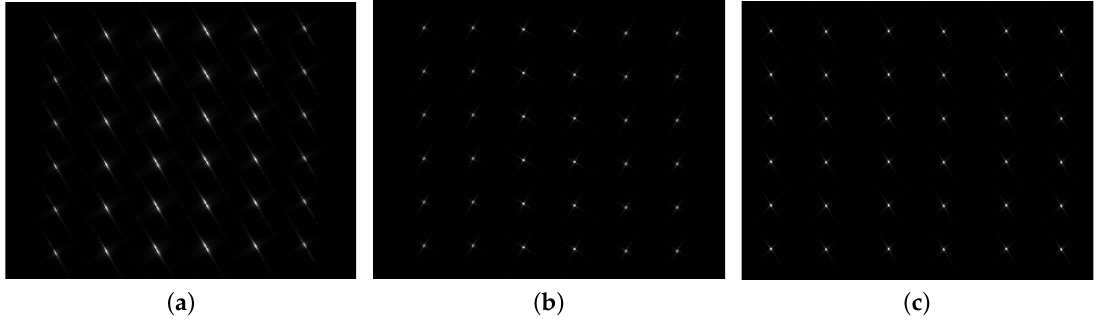
Figure 7. Imaging results. ( a ) Nonlinear chirp scaling (NLCS)-based 2-D SVD algorithm with inaccurate movement information. ( b ) NLCS-based 2-D SVD algorithm with accurate movement information. ( c ) The proposed